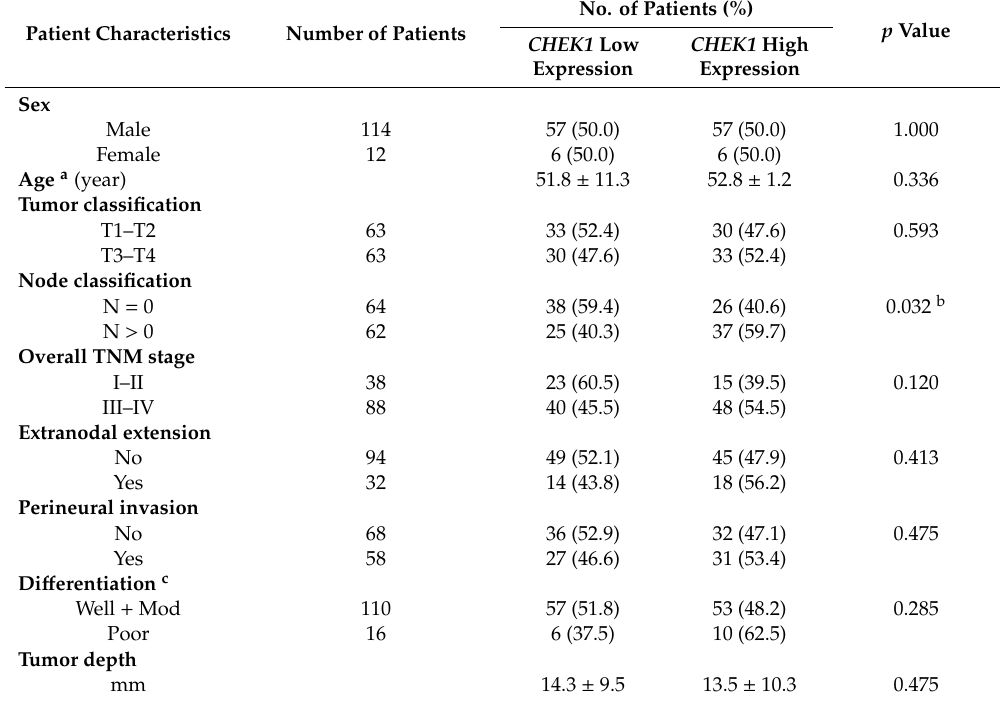
Table 2. Associations of the clinicopathological characteristics with CHEK1 expression levels in the 126 OSCC patients in this